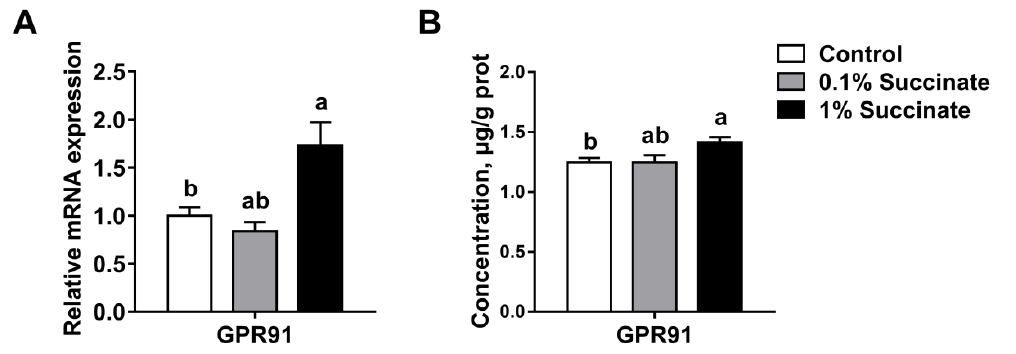
Figure 5. Effects of sodium succinate on the mRNA expression ( A ) and protein concentration ( B ) of GPR91 in the jejunum of pigs.